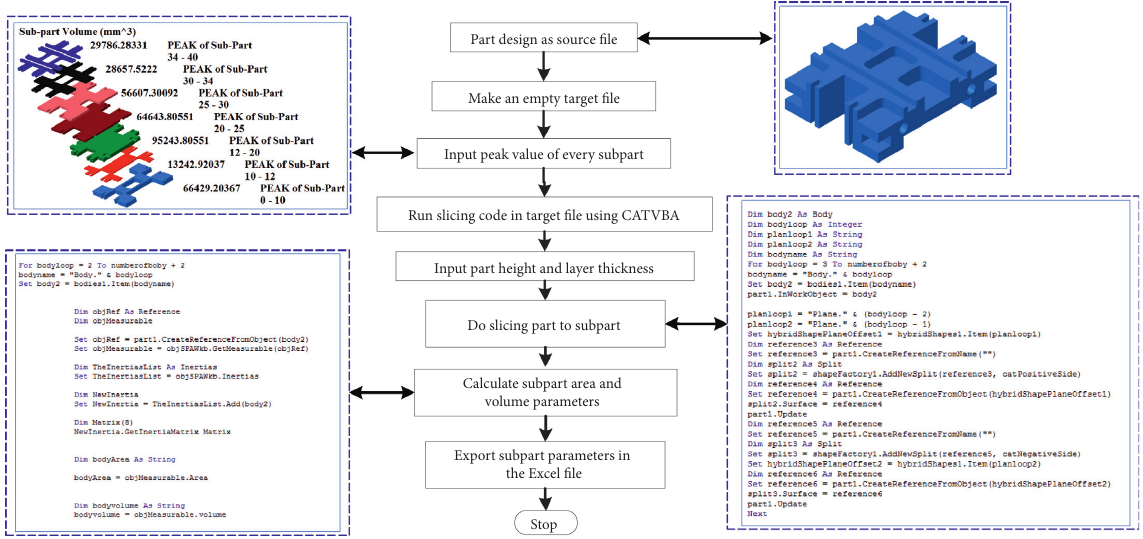
Figure 4: Automatic slicing of a part to a subpart [24].